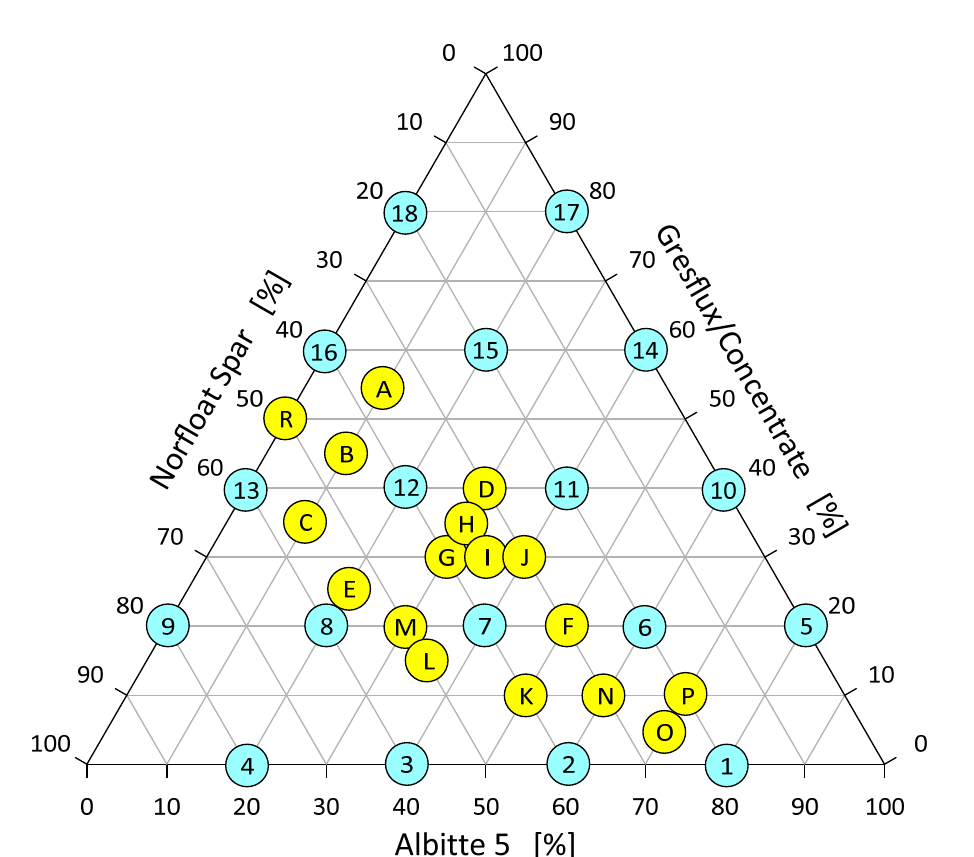
Figure 1. Distribution of samples in the spodumene–albite–microcline triangle. To determine the effect of enrichment and grinding of the lithium component, en- riched and micronized spodumene Concentrate with an average grain size of d 50 = 3 µm and ground spodumene Gresflux with a starting grain size of d 50 = 180 µm were intro- duced into the sets. Regardless of the degree of grinding, all sets were additionally ho- mogenized for about 15 min in an alumina mill Fritsch pulverisette MV46 (Idar-Ober- stein,Germany). The average grain size distribution of the sets did not exceed 50 µm.